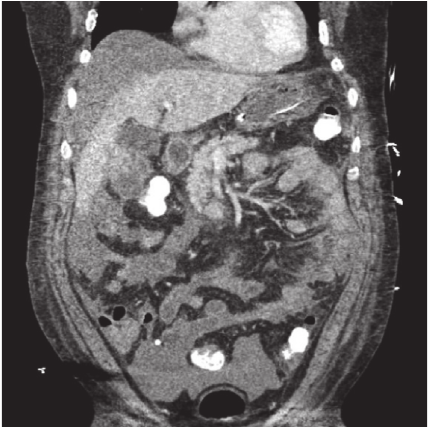
Figure 3: CT scan of abdomen and pelvic showing a mass at seg- ment 5 of